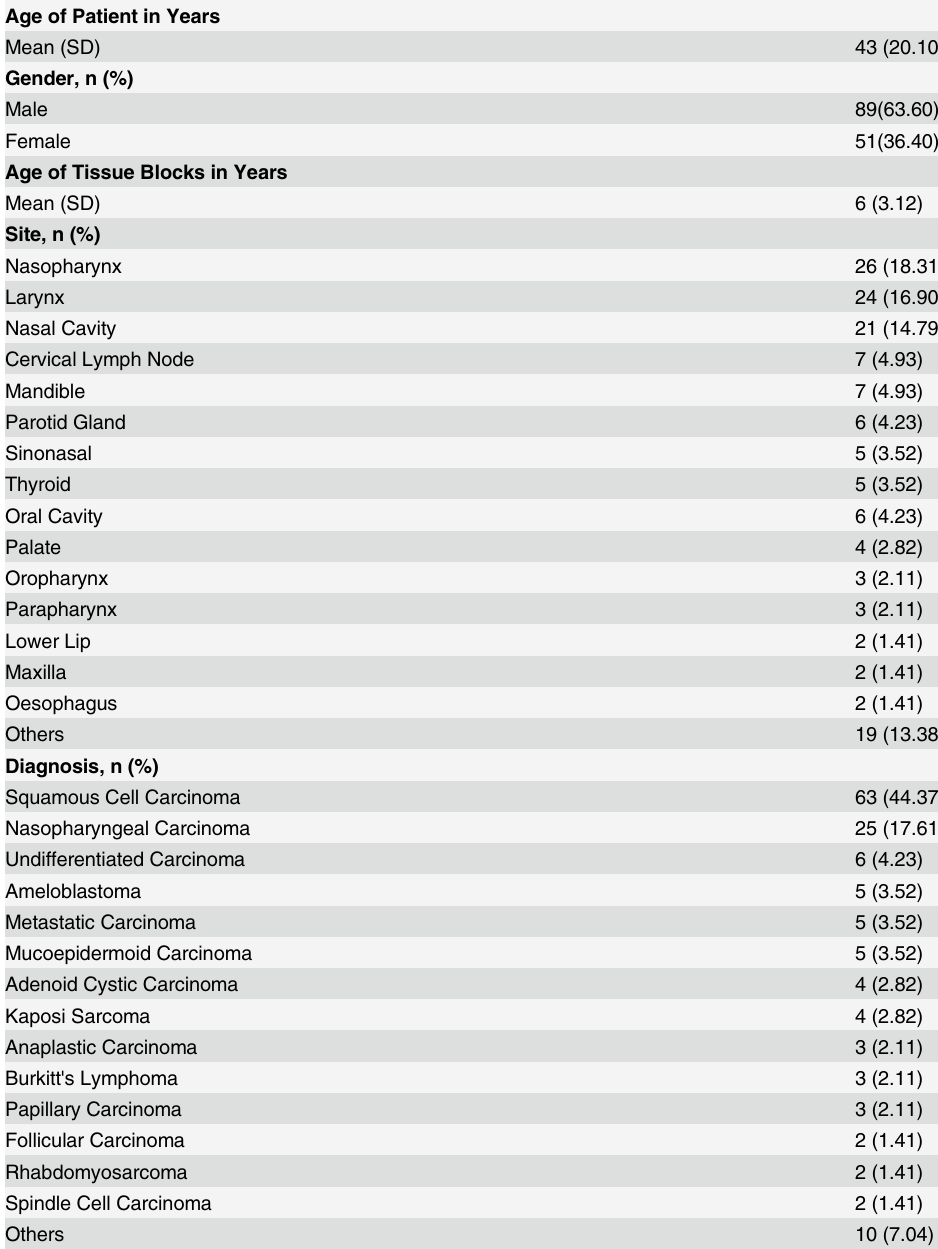
Table 1. Characteristics of Samples (N =